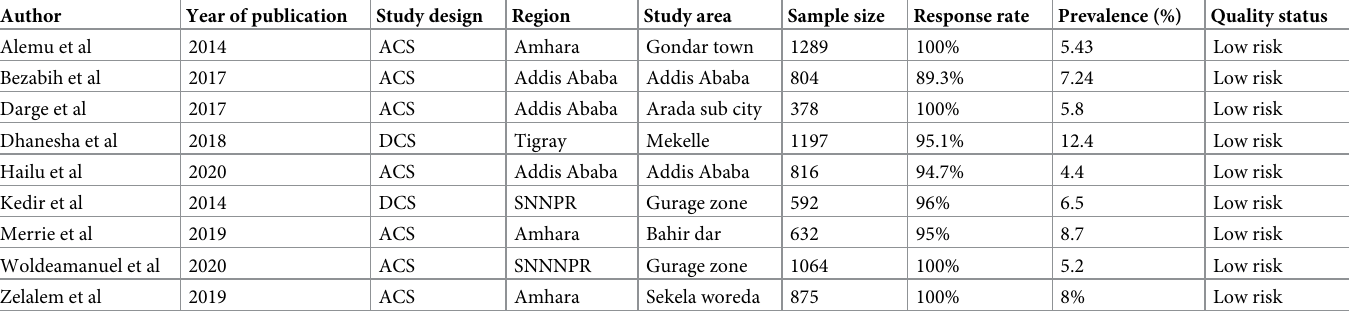
Table 1. Descriptive summary of 9 studies reporting the prevalence and associated factors of visual impairment among children in Ethiopia included in the system- atic review and meta-analysis, 2021.